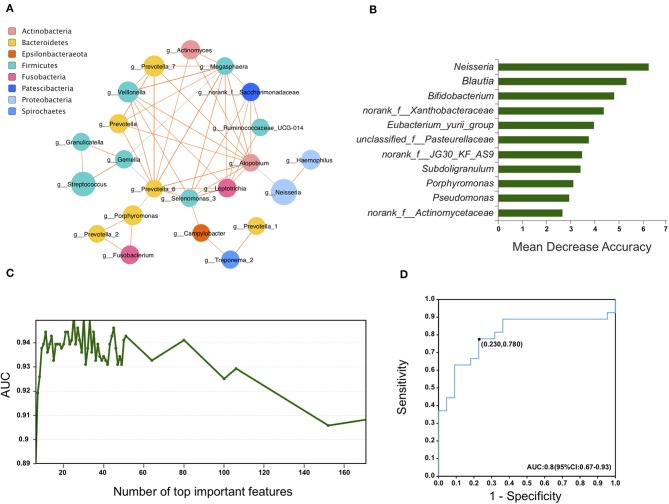
Saliva bacterial biomarkers characterizes RA patients. (A) Plots of co-abundance and co-exclusion association networks between differentially abundant genera. Each node represents one genus. The node size is proportional to the mean relative abundance of the genus in all samples. Node color indicates the phylum it belongs to. Lines between nodes show positive correlations (solid orange lines) or negative correlations (dashed green lines). Line width is proportional to the value of Spearman correlation coefficient and reflects the magnitude of association. (B–D) A random forest model was applied to identify bacterial biomarkers for RA patients. Ranked lists of genera in order of random forests reporting feature importance scores were obtained (B) and an AUC-validation method was used to determine the optimal genera set (C). The built ROC curve based on the selected panel of 11 genera yield an AUC of 0.8 (D).